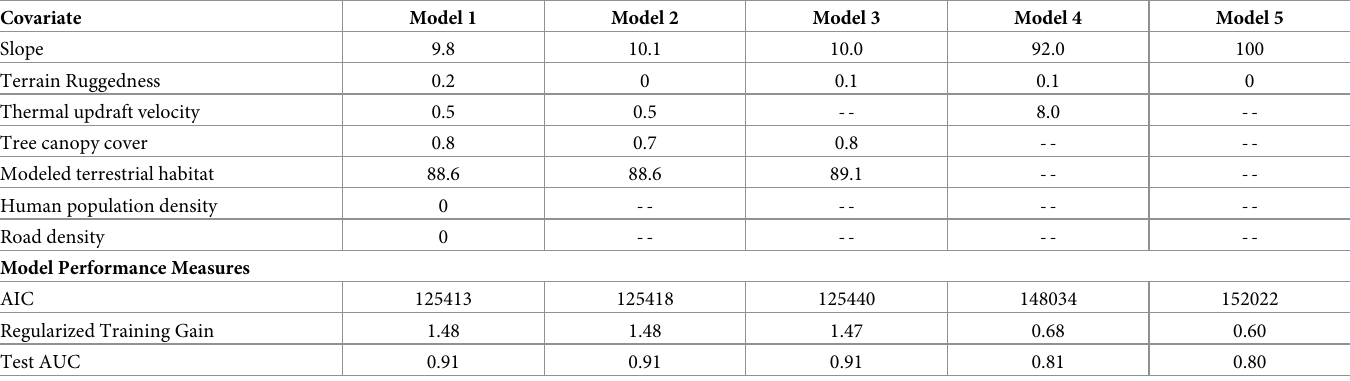
Table 2. Mean relative contribution of covariates (%), and measures of model performance for a California condor landscape conductance surface (Some columns in the upper portion of the table do not sum to 100 due to rounding). Covariate